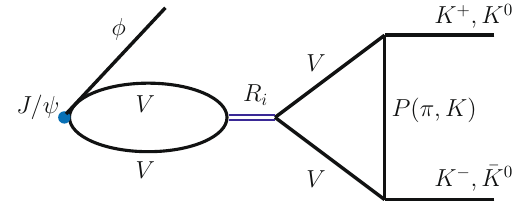
Fig. 1 Mechanism for the production of the resonances R i = f 0 ( 1710 ), a 0 ( 1780 ) with further decay to K + K − , K 0 ¯ K 0 ; P